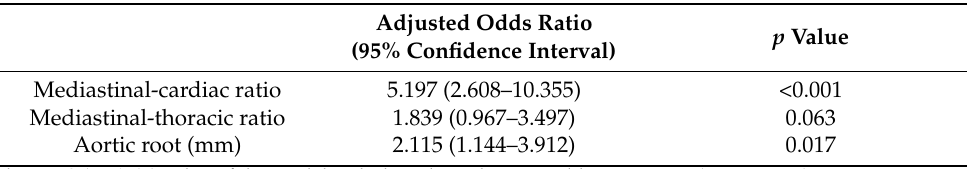
Table 4. Multivariable logistic regression analysis to predict catheter